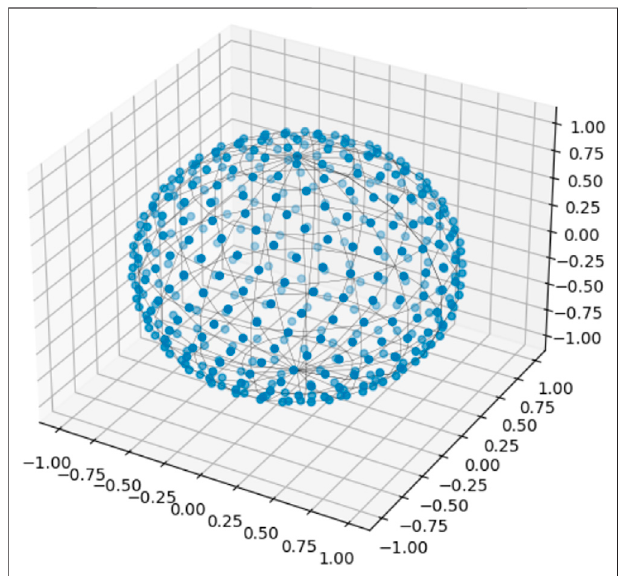
FIGURE2| 400points generateduniformlyonthesurfaceofasphere in 3-dimensional space using the combination of Monte Carlo theory and Fibonacci spiral